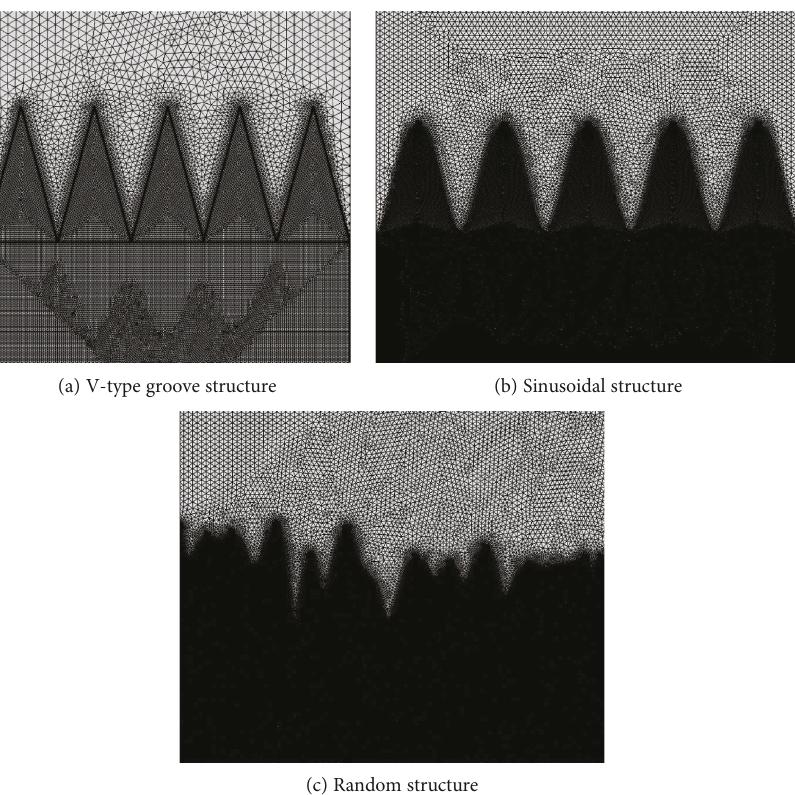
Figure 4: Mesh subdivision diagram of three surface structures.